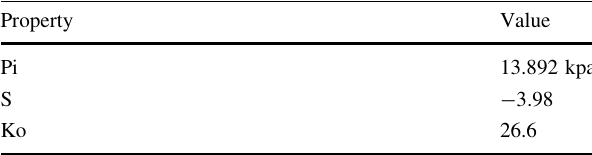
Table 4 Deconvolution simulation